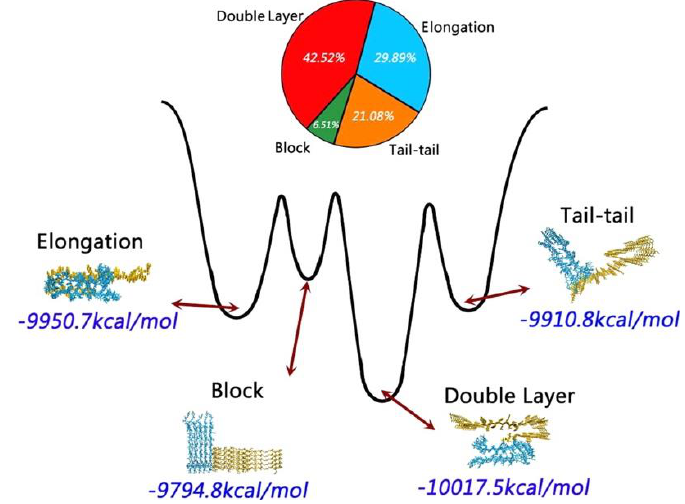
Figure 21. Structural ensemble of hetero-pentamers of Aβ 42 -hIAPP, showing their relative proportion and free energies for their mutual orientations. Adapted from Zhang et al. [131]. Copyright 2015 American Chemical Society.